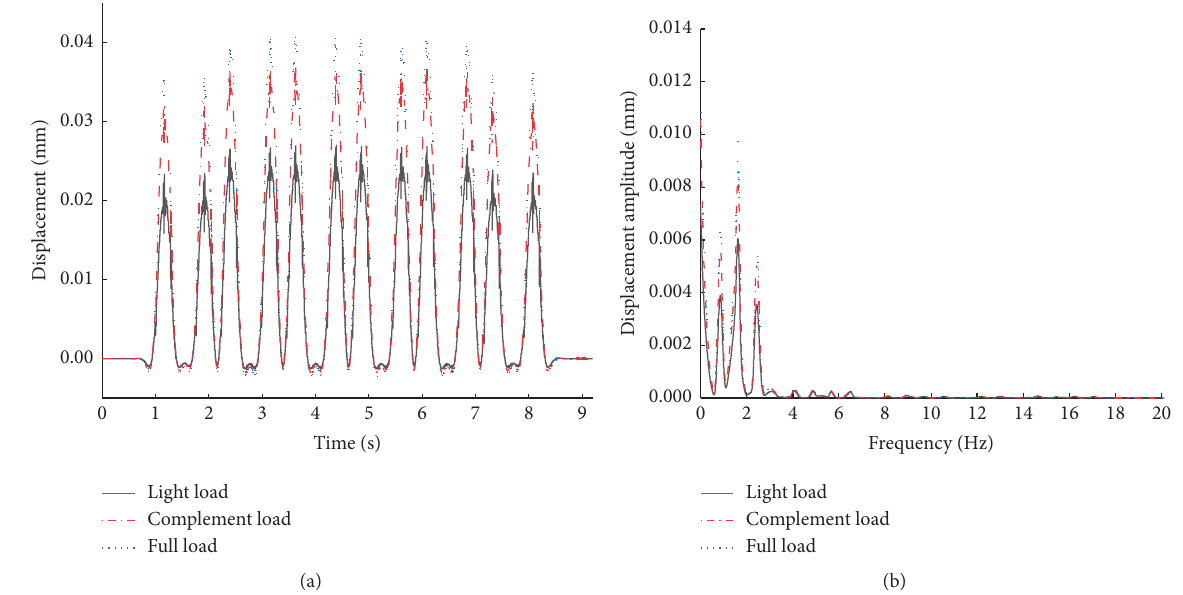
Figure 8: (a) Time-history and (b) amplitude-frequency curves of vertical displacement of left monitoring point of track bed under different axle